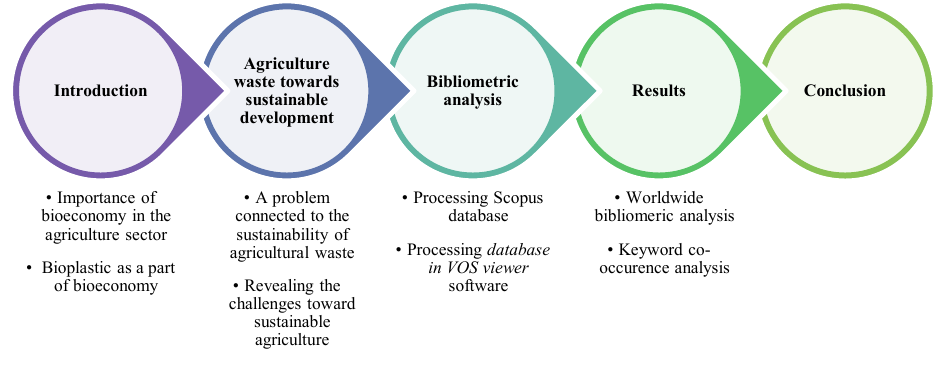
Fig. 1. The overall structure of the